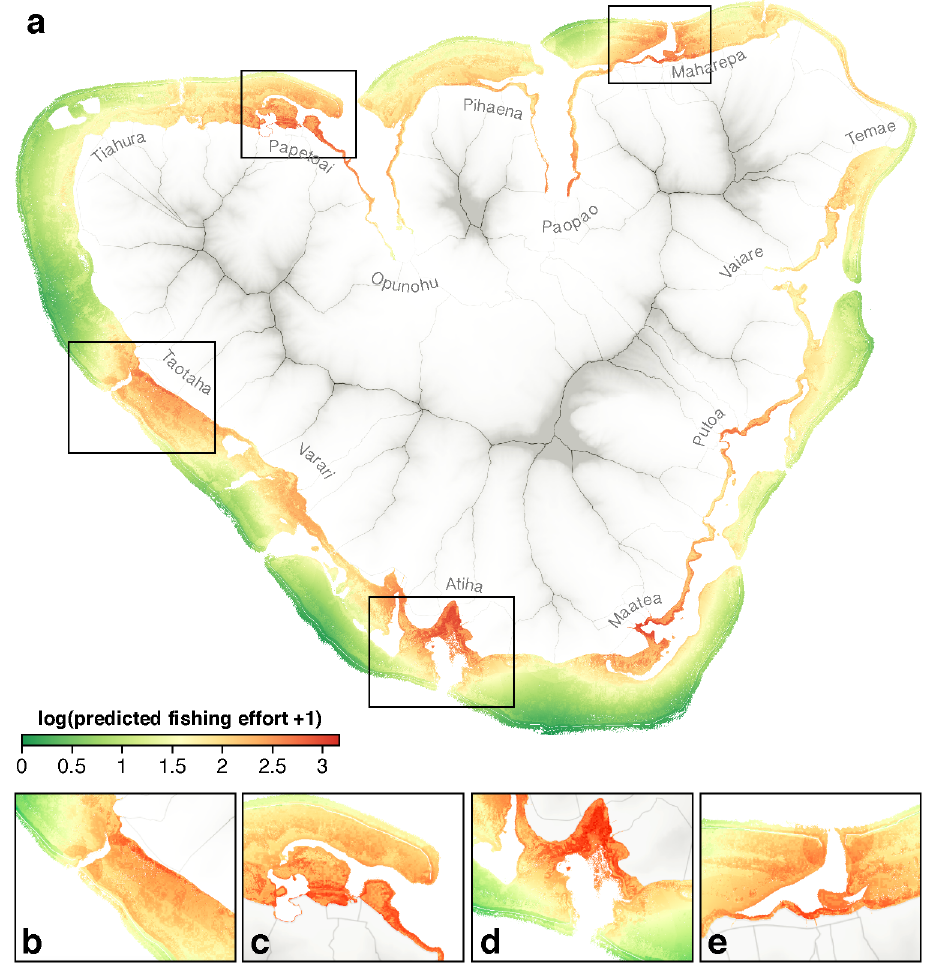
Fig 4. Spatial variation in predicted fishing effort. (a) Island-wide analysishighlightsa high level of fine- scale spatial variation in predictedfishingeffort. Highly exposedareas include(b) Taotaha, (c) Papetoai,(d) Atiha and (e) Maharepa